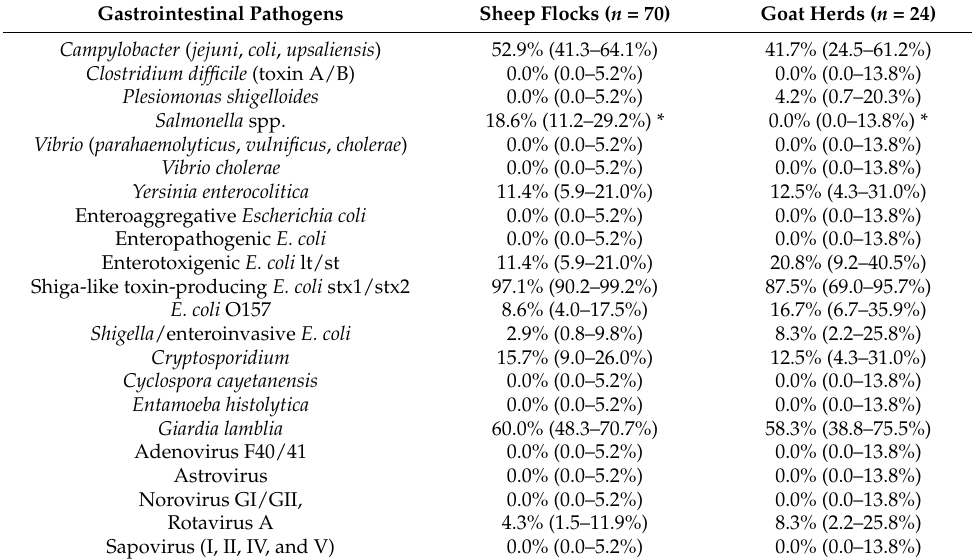
Table 1. Prevalence (95% confidence intervals) of detection of gastrointestinal pathogens in small ruminant farms ( n = 94) in Greece, as found by means of the BioFire ® FilmArray ® Gastrointestinal (GI) Panel